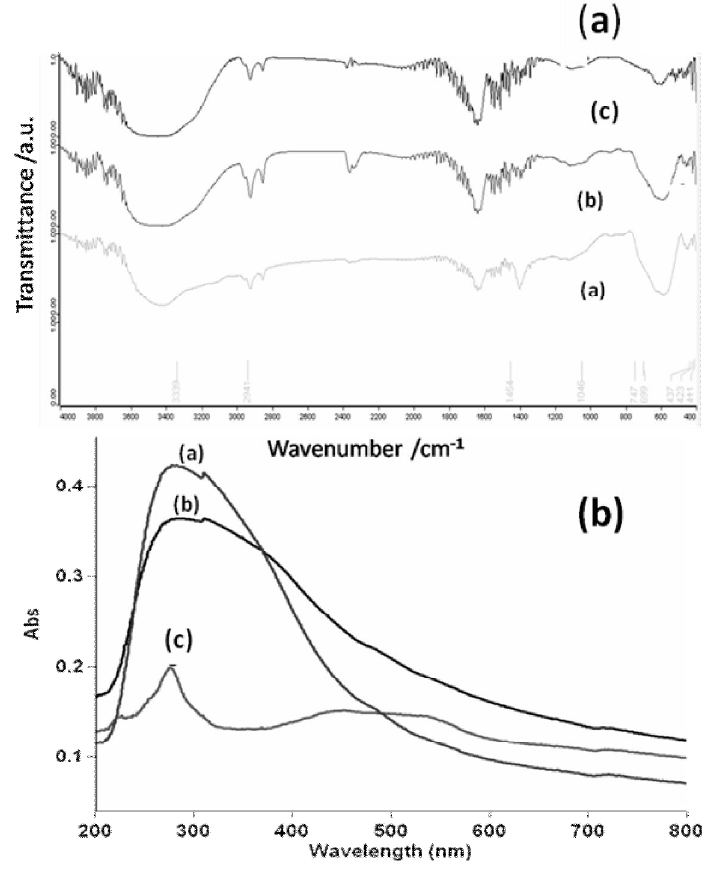
Fig. 2. (a) FT-IR and (b) UV-Vis spectra of a: Fe and c: TiO